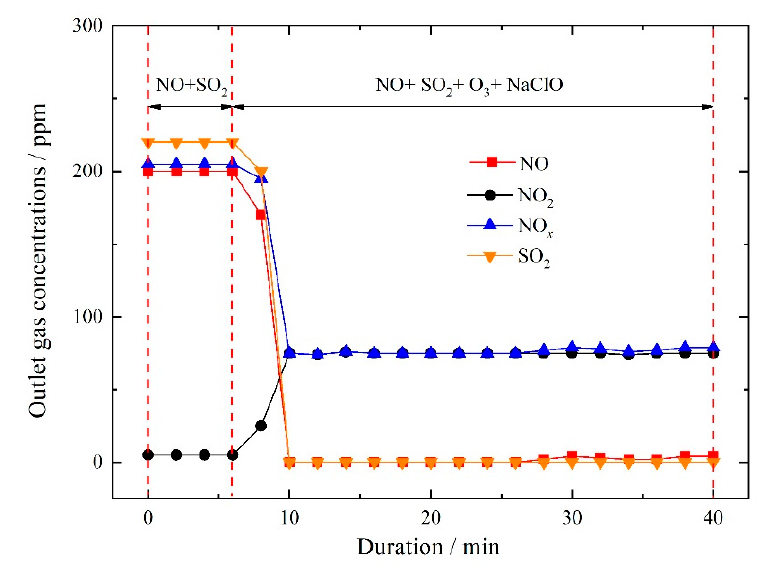
Figure 9. The changes of outlet gas concentrations with the reaction duration in the test of in-situ combination of 100 ppm ozone injection and wet scrubbing 0.04 mol·L − 1 NaClO solution. combination of 100 ppm ozone injection and wet scrubbing 0.04 mol